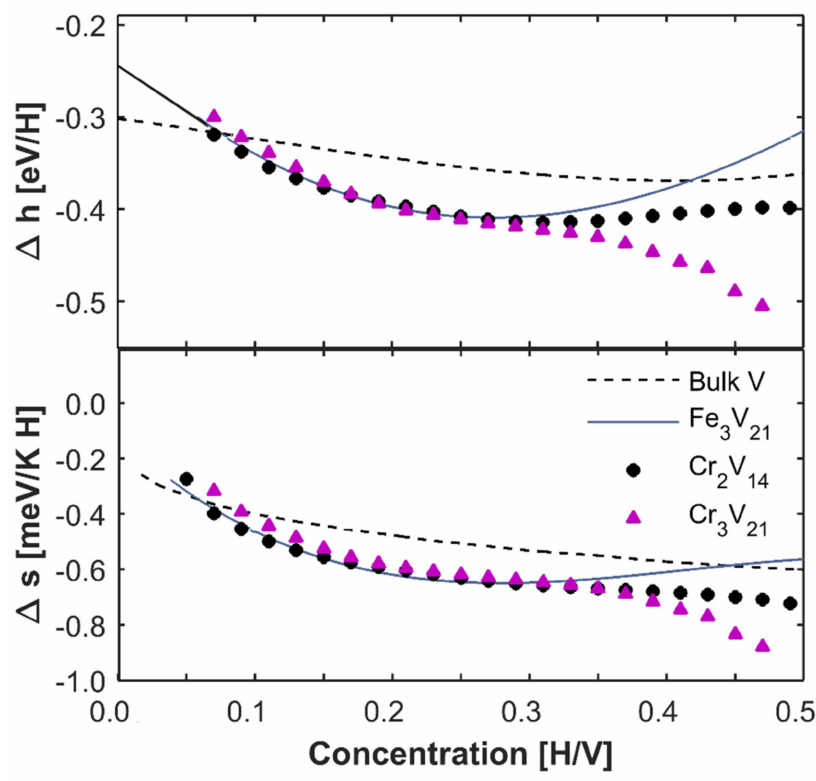
Figure 3. Enthalpy ∆ h (upper panel) and entropy ∆ s (lower panel) as a function of H concentration for Cr 2 /V 14 and Cr 3 /V 21 superlattices. The results for bulk V and Fe 3 /V 21 superlattice are shown for comparison